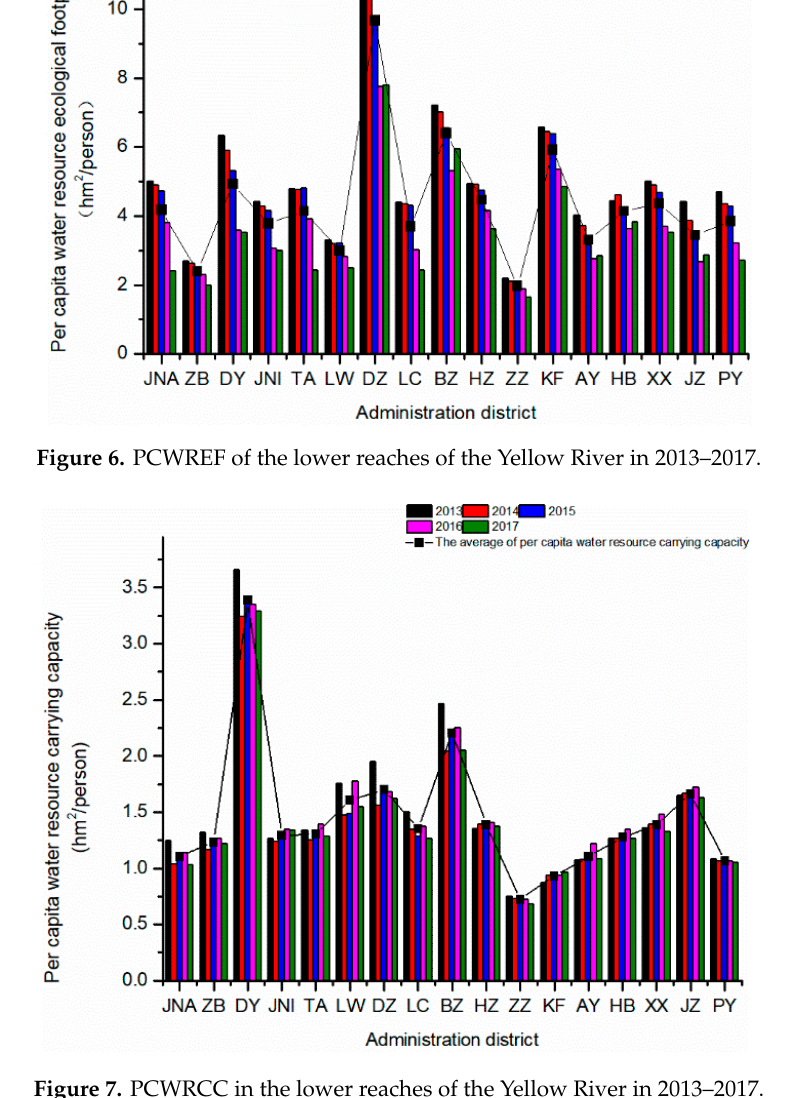
Figure 7. PCWRCC in the lower reaches of the Yellow River in